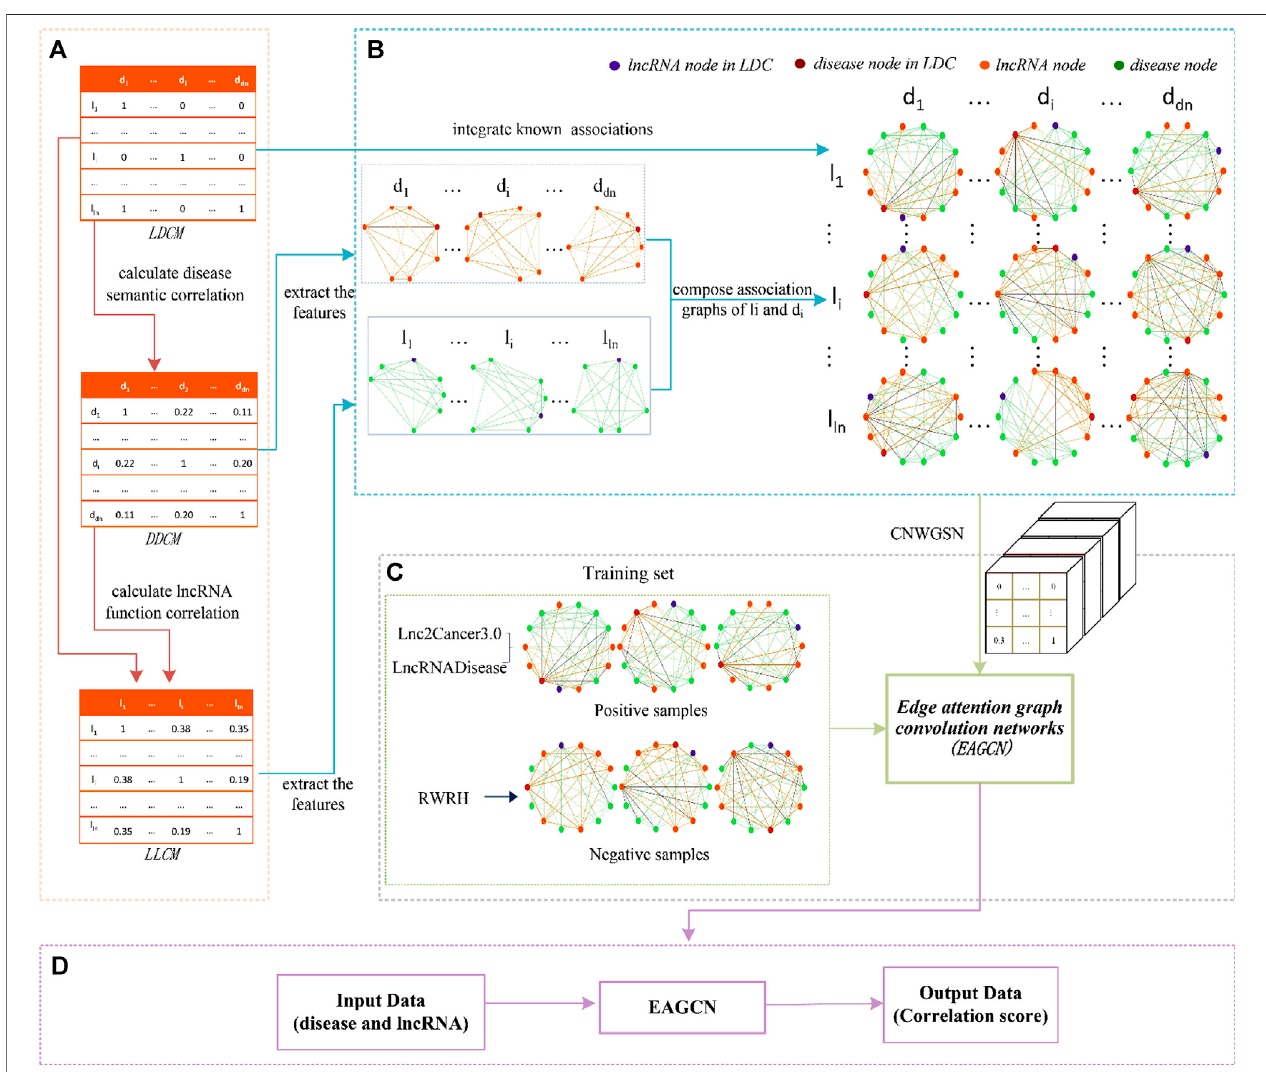
FIGURE 2 | Flowchart of LDA-EAGCN. (A) Construction and calculation of lncRNA – disease correlation matrix (LDCM), disease – disease semantic correlation matrix (DDSCM), and lncRNA – lncRNA function correlation matrix; (B) constructing the closest lncRNA node weight graph (CLNWG) of the lncRNA and disease in lncRNA – disease correlations (LDCs); (C) training edge attention graph convolution networks (EAGCN); (D) predicting correlation scores of input data with